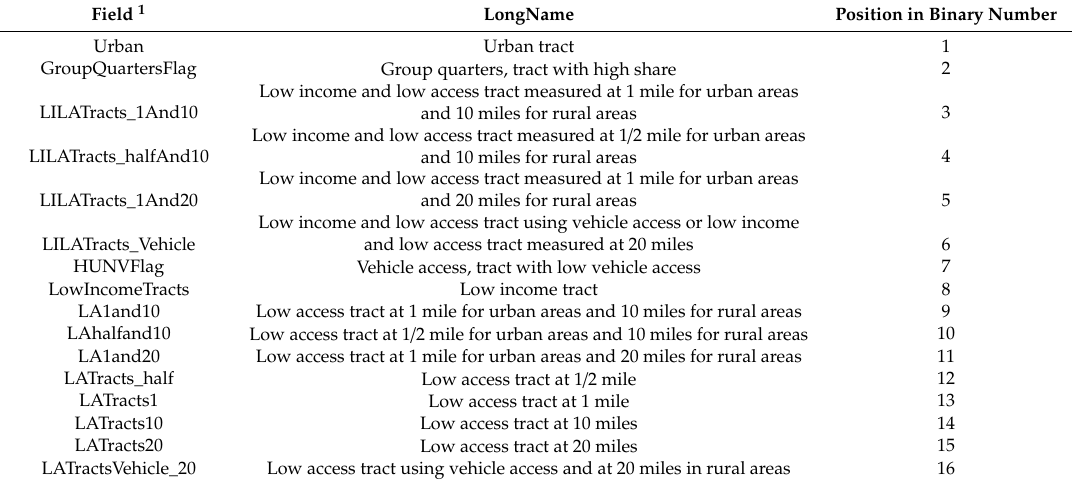
Table 1. Variables in Food Access Research Atlas for constructing binary number for census